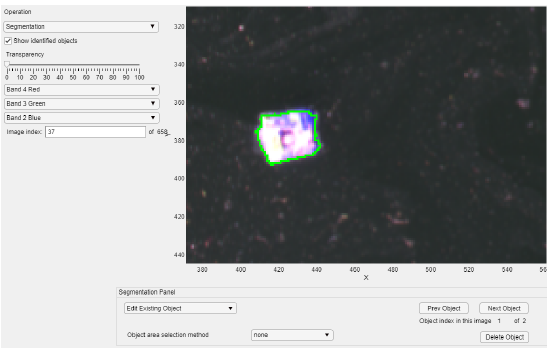
Figure 13. Example of 1-click segmentation.